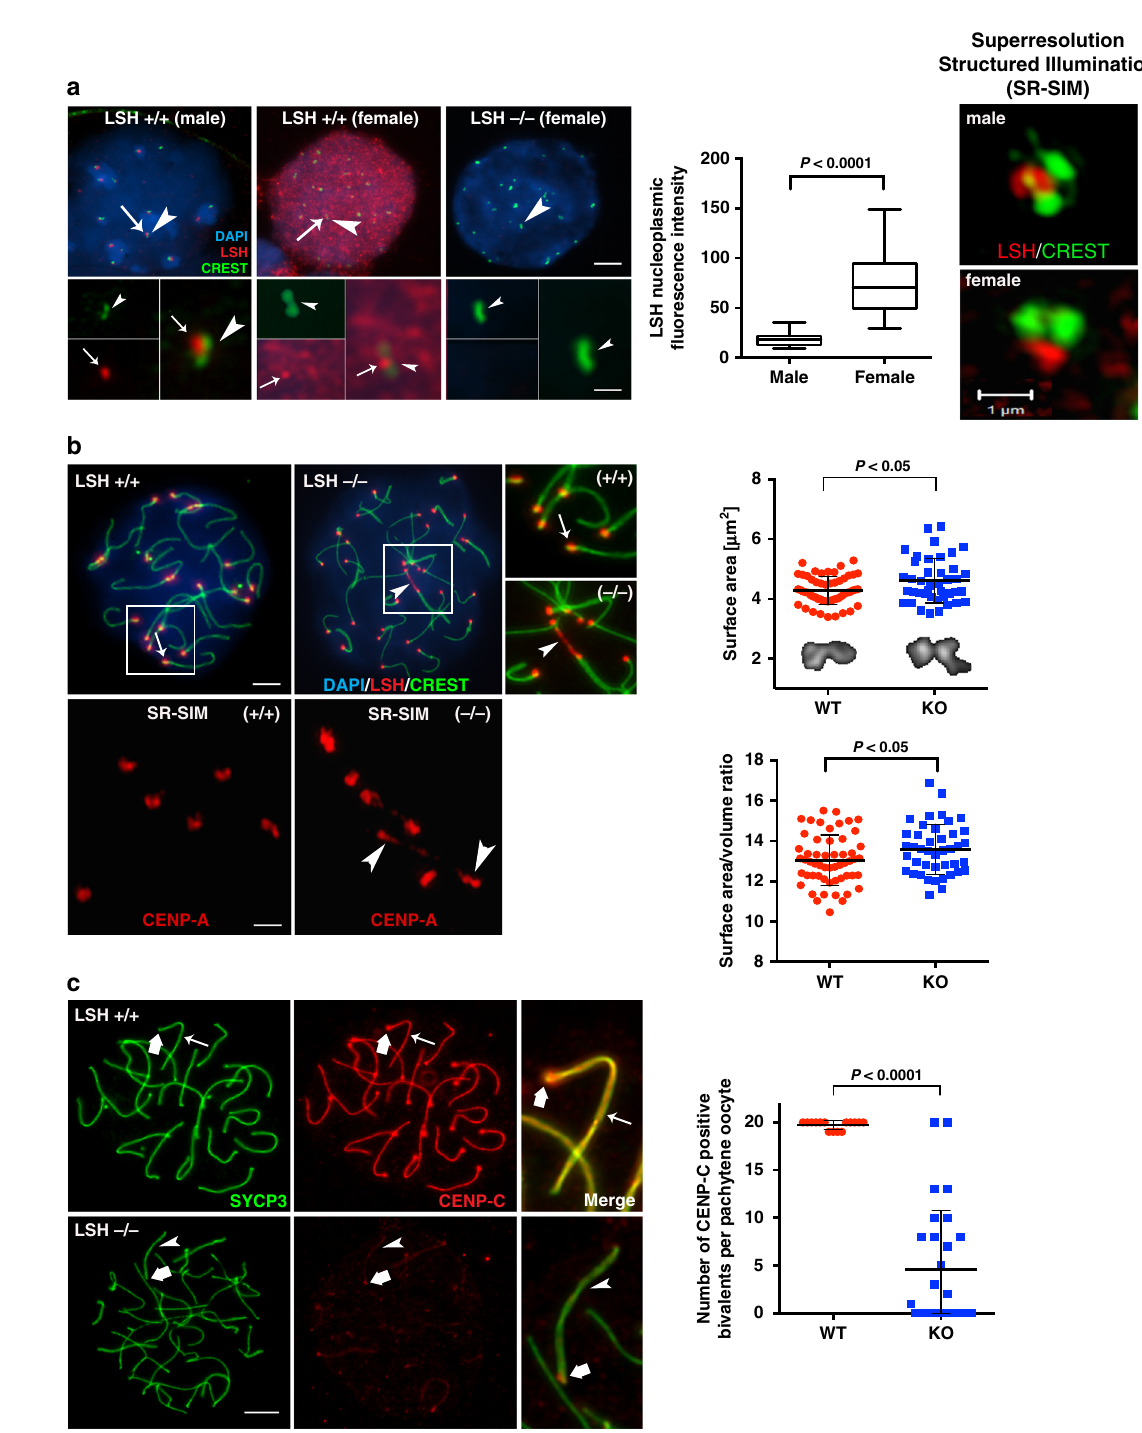
H3T3ph is a prominent posttranslational modi fi cation required for inner centromere speci fi cation 8,9 . However, the mechanisms regulating inner centromere chromatin modi fi ca- tions are not clear at present. In wild-type oocytes, H3T3ph is localized at the kinetochore in pachytene oocytes with fully synapsed bivalents (Fig. 2a; arrowheads and inset). Notably, LSH mutant oocytes exhibit a signi fi cant increase in the levels of H3T3ph where this histone mark becomes a diffuse nucleoplas- mic signal (Fig. 2a). High-resolution chromatin analysis indicates the presence of abnormal chromosome contacts and interactions mediated by protruding chromatin fi bers, proximal to the